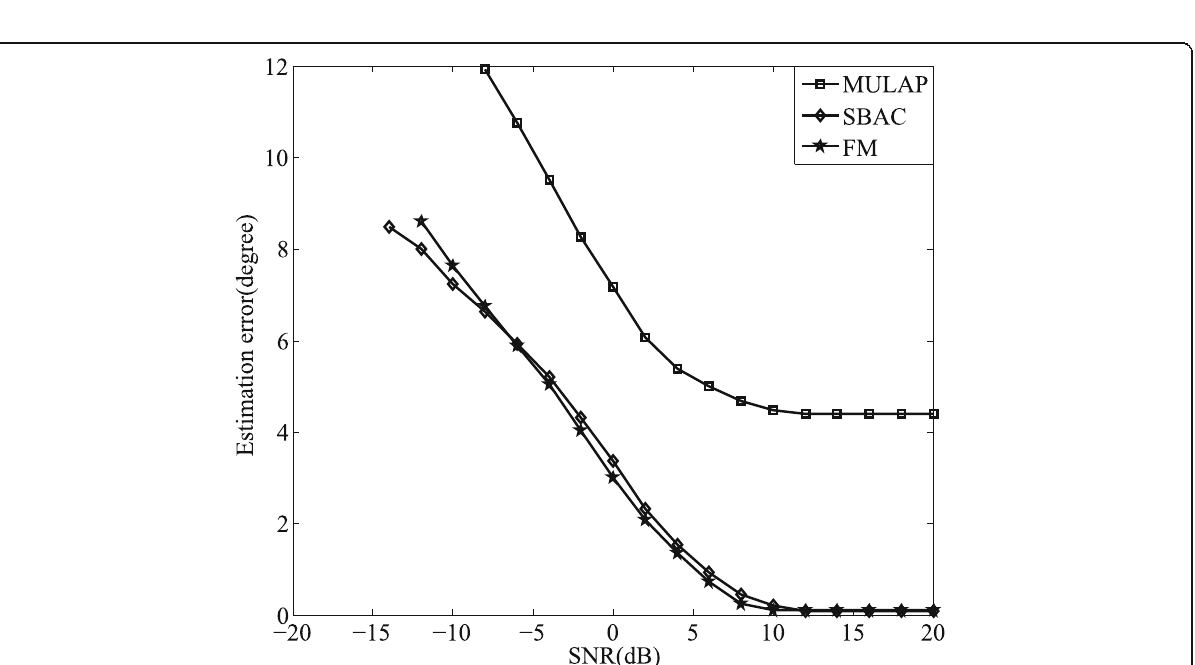
Fig. 4 Estimation errors versus